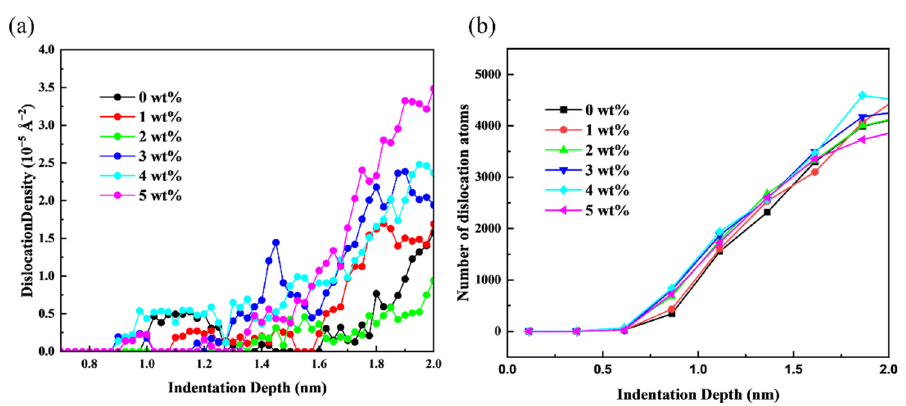
Figure 7. Plotting of the dislocation density and defective atoms number variations of five different Zr content of Nb-Zr alloys during indentation at 296 K. ( a ) Dislocation density and ( b ) Number of defective atoms variations.